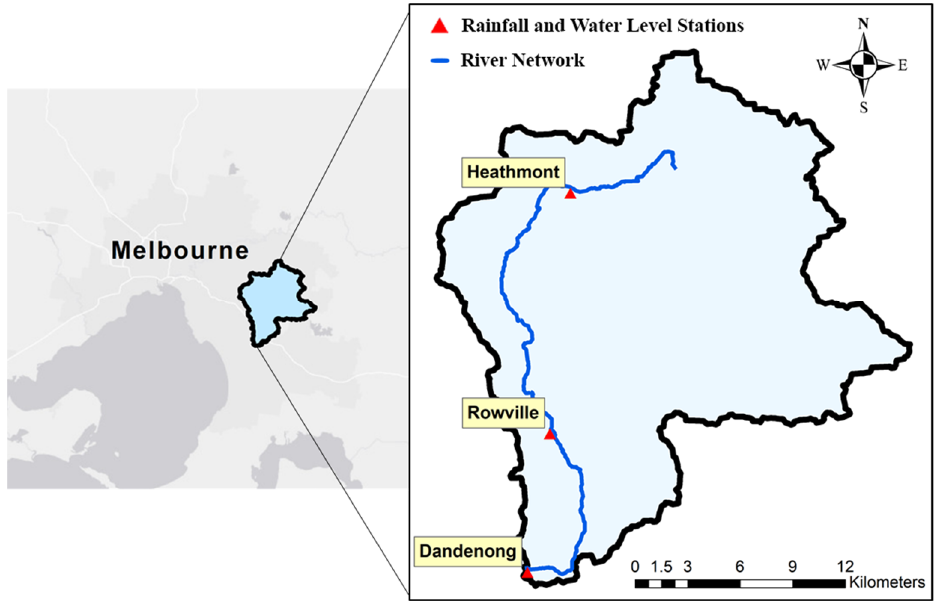
Figure 2. Schematic map of Dandenong catchment.